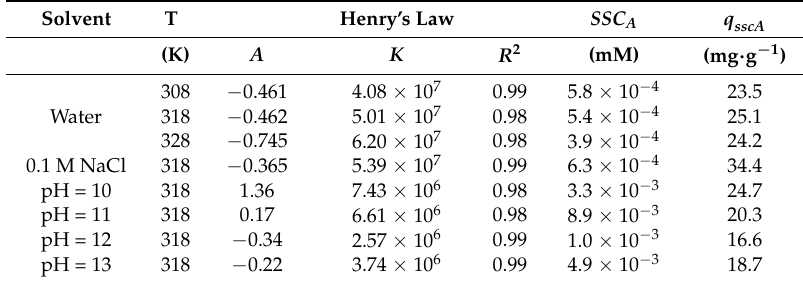
Figure 8. ( a ) Orange G and ( b ) adsorption sites of GO/PAMAM to CR. PB is an abbreviation for PAMAM BODY. Table 1. The SSC A and q sscA values and parameters that were obtained from the Henry’s law for the adsorption of CR on GO/PAMAM in water and 0.1 M NaCl solutions in region I at 308–328 K.